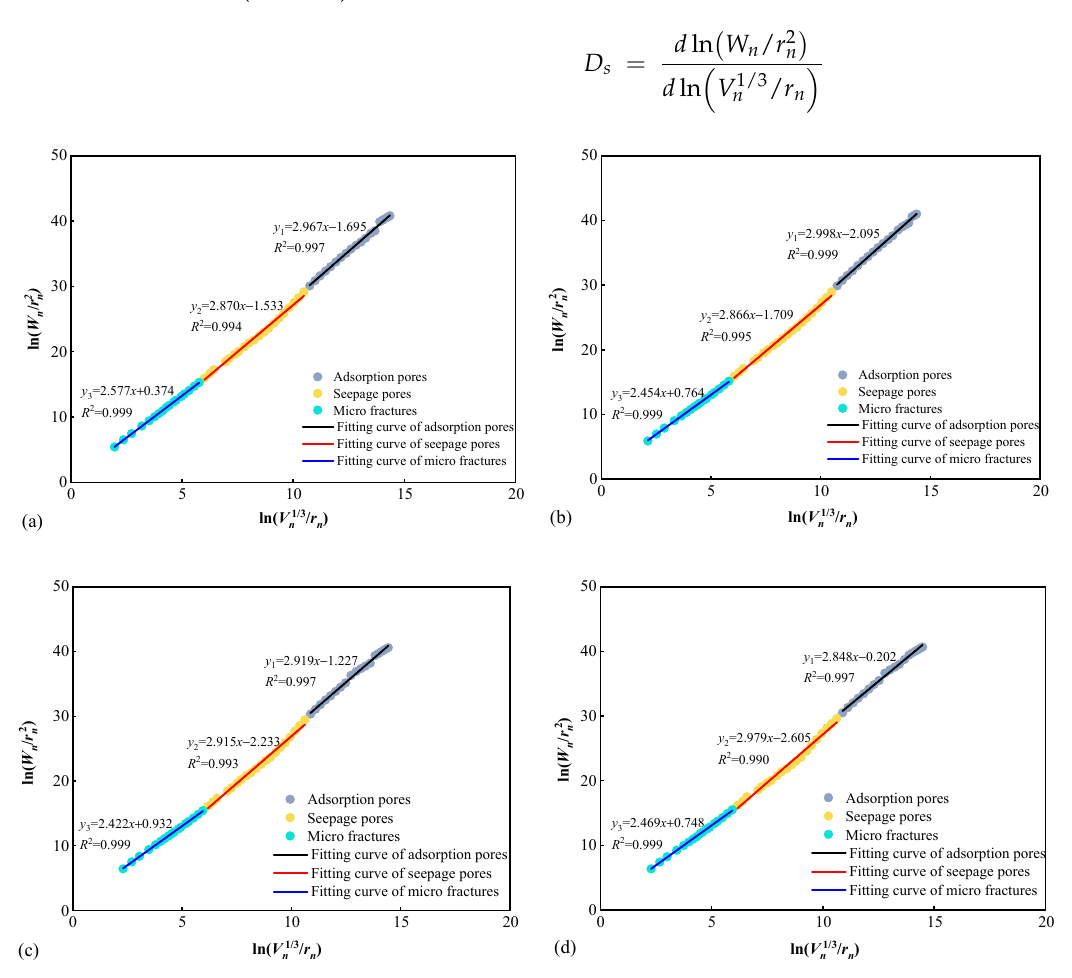
Figure 6. Surface fractal dimensions of coal samples. ( a ) XZY-1; ( b ) XZY-2; ( c ) XZY-3; ( d ) XZY-4.